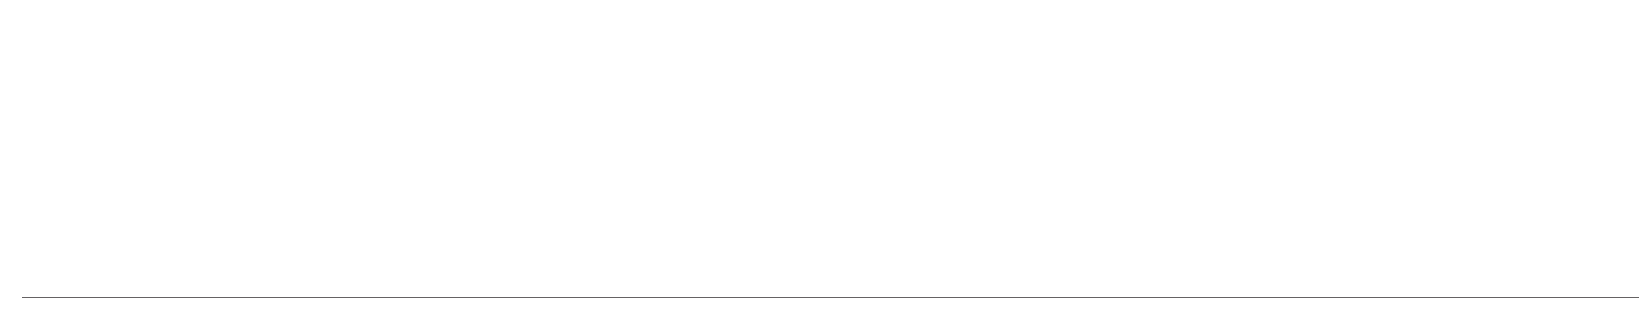
TABLE 4 | Diagnostic performance of the different biomarkers comparing MSARD to OIND ( n = 123). TP ( n